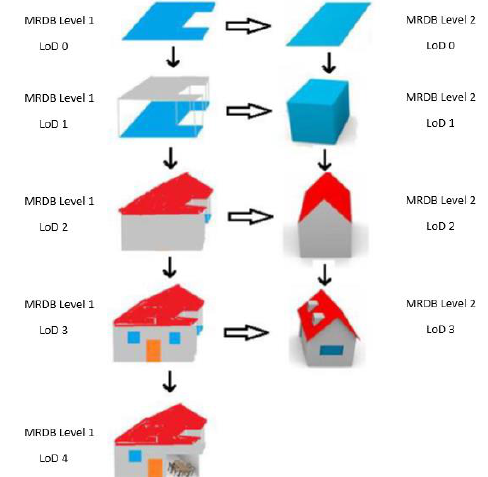
Figure 4. Combination of Figure 1 and Figure 2 for buildings.